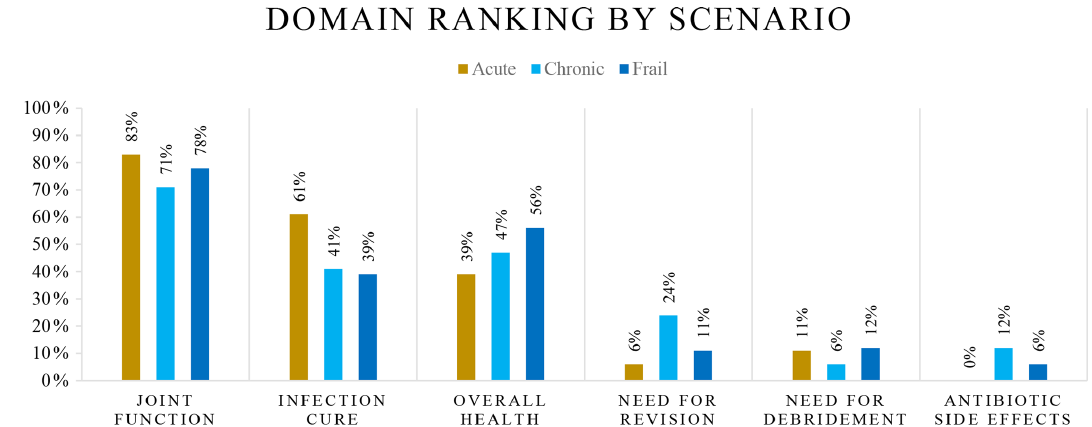
Figure 2. Domain ranking for general ranking experiments in the first round of the Delphi process. Percentages shown as a cumulative number of respondents who selected the domain as the most important or second most important from the ranking